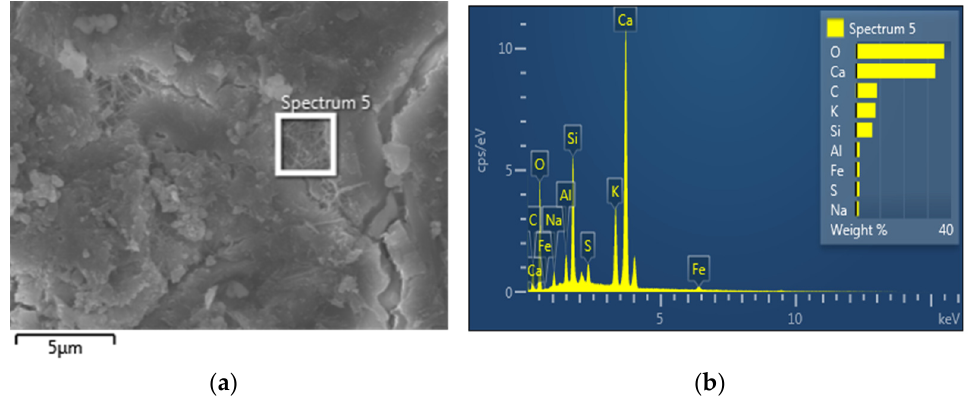
Figure 14. EDS results of cement paste containing CNT-TEOS/PVP NFs: ( a ) SEM image; ( b ) EDS spectrum—focus on nanofibers zone.